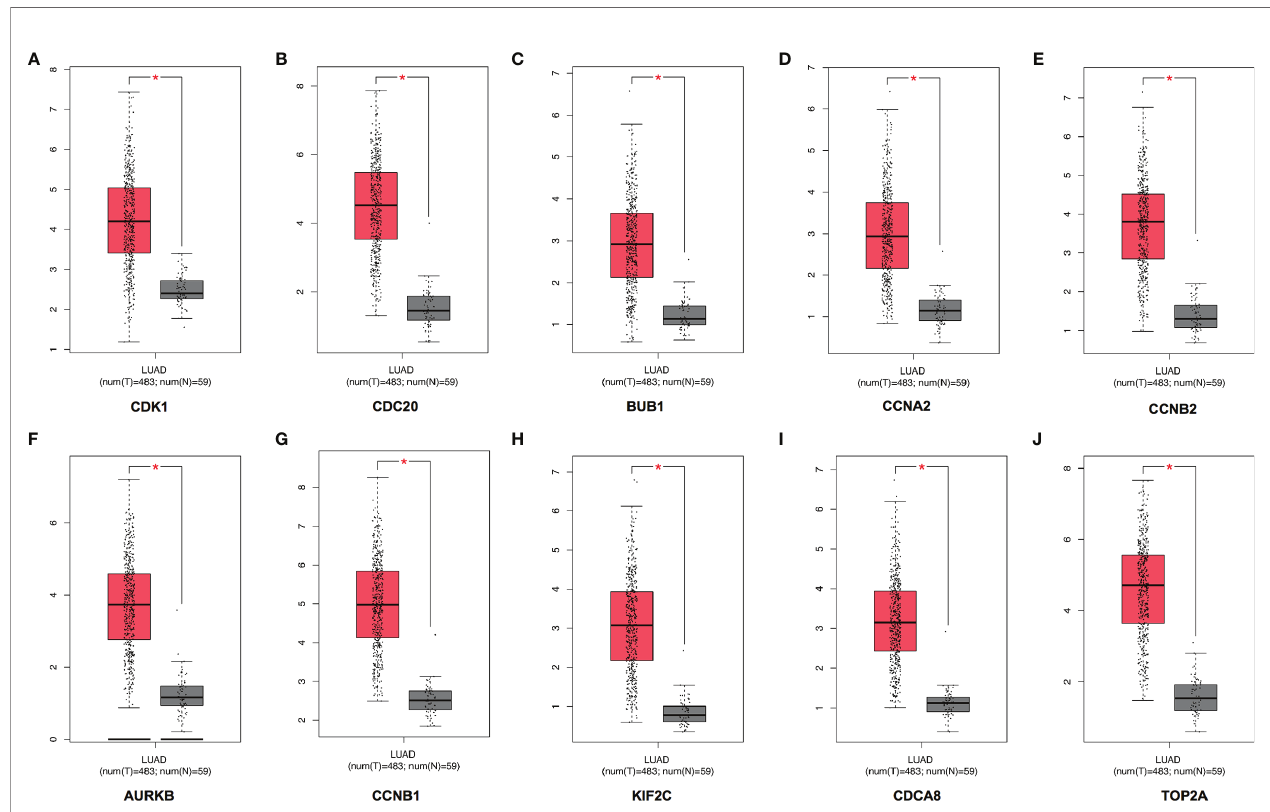
FIGURE 11 | Expression of the top 10 hub genes in LUAD in the GEPIA database. The expressions of CDK1 (A) , CDC20 (B) , BUB1 (C) , CCNA2 (D) , CCNB2 (E) , AURKB (F) , CCNB1 (G ), KIF2C (H) , CDCA8 (I) , and TOP2A (J) in LUAD. LUAD, lung adenocarcinoma. *p <